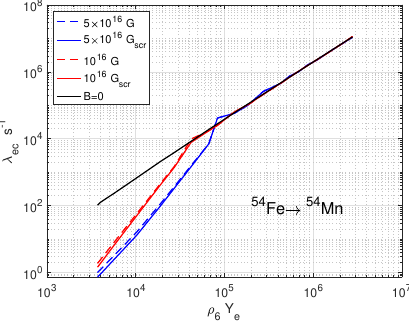
Figure 2. The reaction rate of 54 Fe( e − ,ν e ) 54 Mn as a function of ρ Y e . Blue lines correspond to a 10 15 G magnetic field. Red lines correspond to a 10 16 G magnetic field, and black lines are the field-free case. The screening corrections are also included as solid lines. This figure is taken from